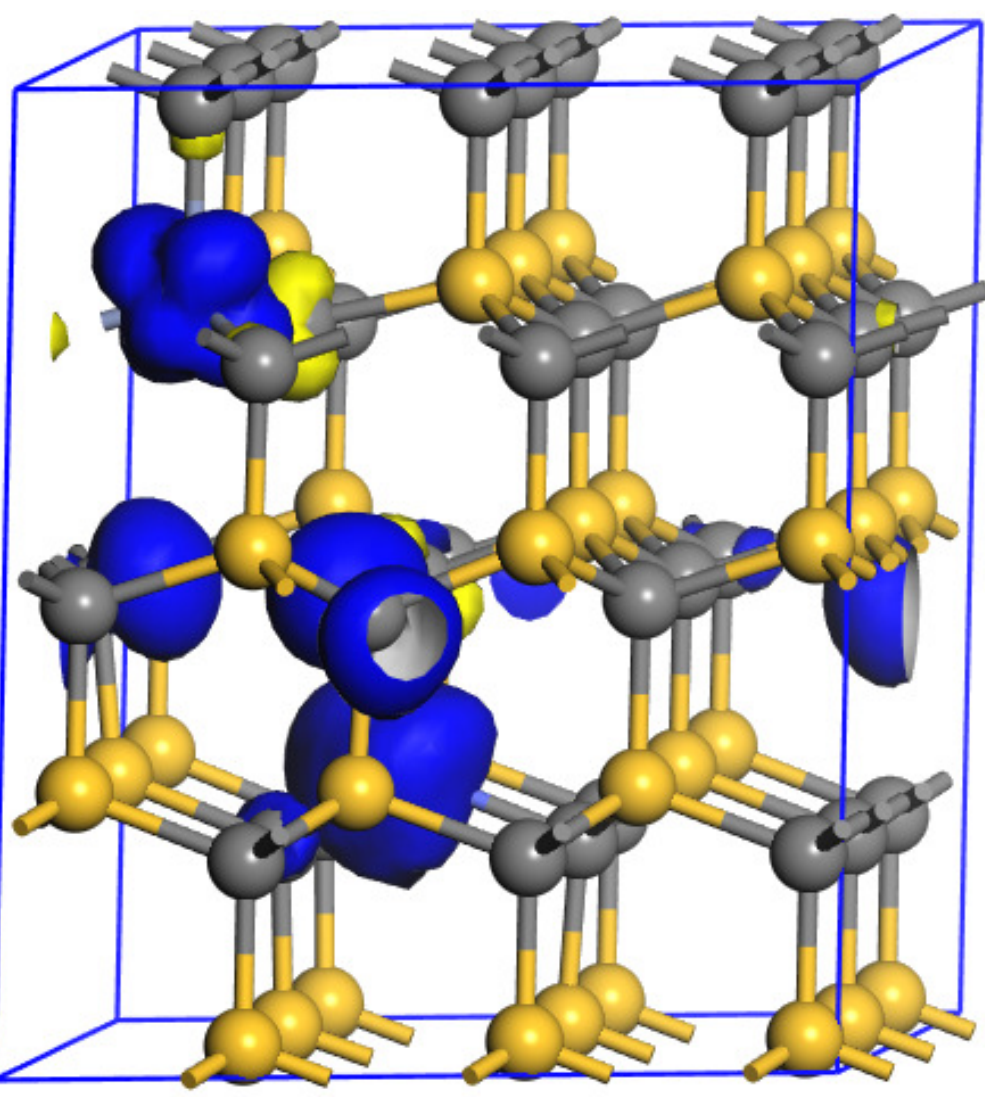
Figure 7. Spin density distribution of (Cr, Co, V Si )-codoped 4H–SiC in ferromagnetism coupling. The blue and cyan yellow display positive and negative spin charge density. The isovalue is set to 0.05 e/ 3